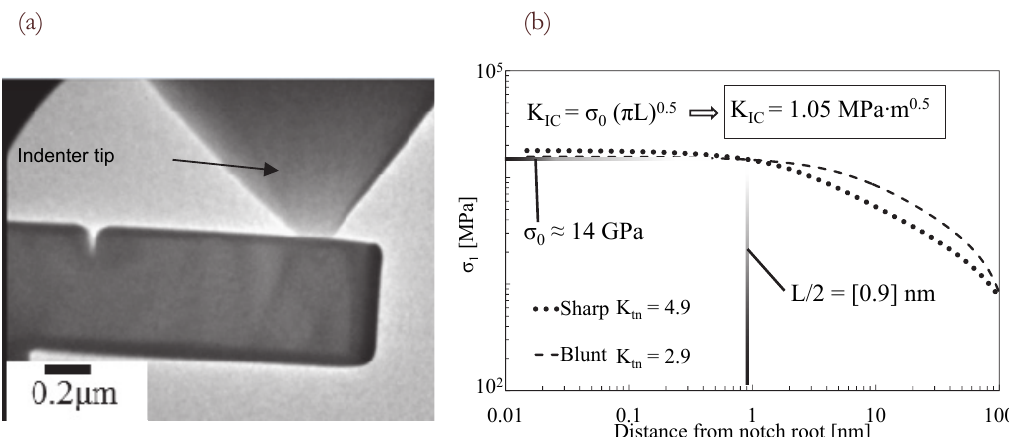
Figure 3: Example of (a) nanoscale notched specimen (TEM image) and (b) synthesis by using the